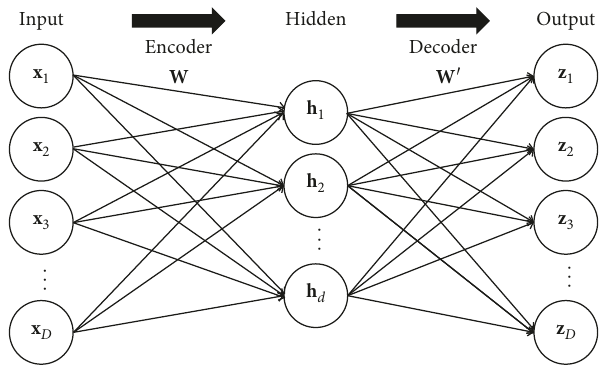
Figure 1: Structure of an auto